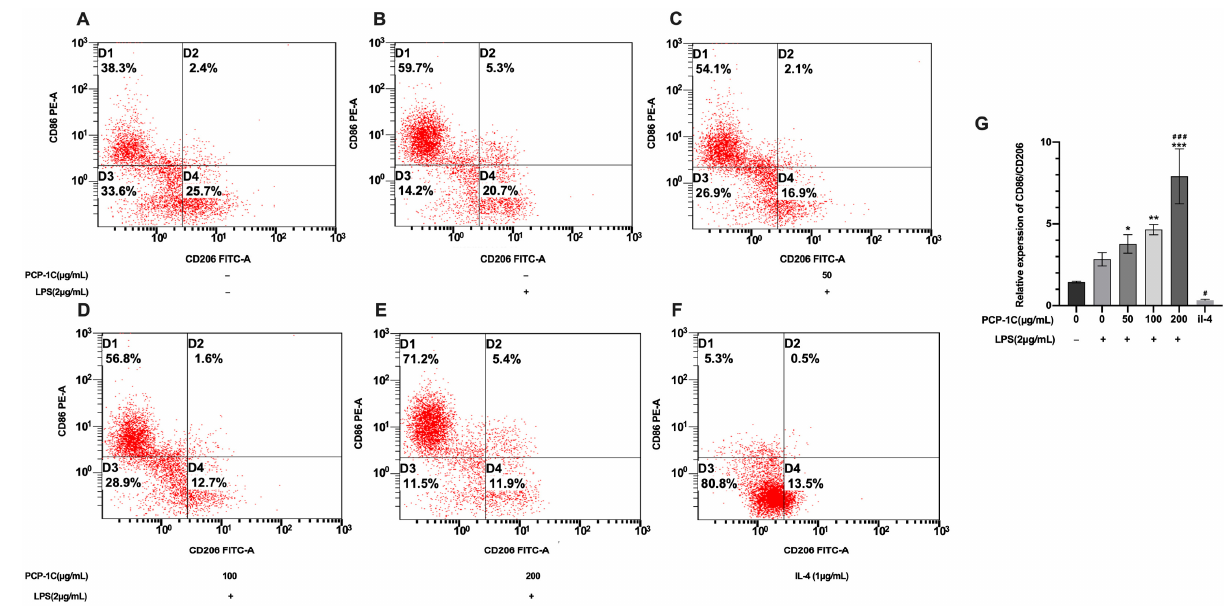
Figure 7. Detection of the surface markers on macrophages by flow cytometry. Macrophages were polarized at 50 µ g/mL, 100 µ g/mL, and 200 µ g/mL PCP-1C and/or LPS for 24 h. We performed flow cytometric analysis on the polarization induced by PCP-1C and LPS in RAW264.7 cells on M1 marker CD86 and M2 marker CD206 ( A – F ). The change in CD86 expression/CD206 expression under the intervention of PCP-1C and LPS ( G ). * p < 0.05, ** p < 0.01, *** p < 0.001 vs. Control, # p < 0.05, ### p < 0.001 vs. LPS; “+” indicates the cells were treated with LPS, while “ − ” indicates they were treated without LPS.